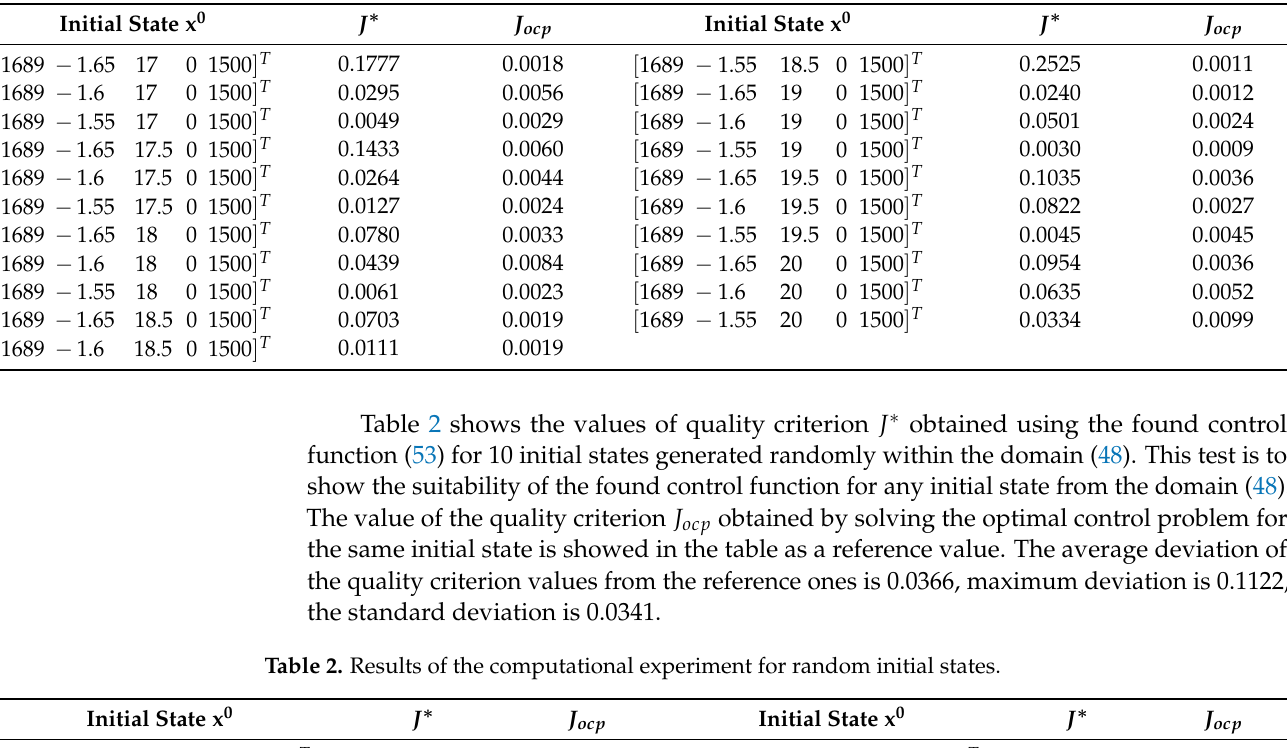
Table 1. Results of the computational experiment using initial states from the training set.